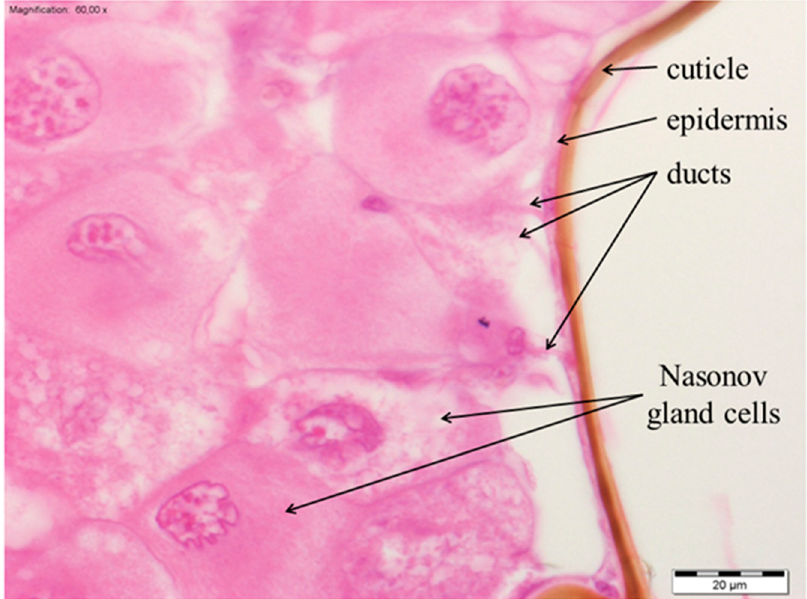
Figure 3. Nasonov gland cells in normal workers. Hematoxylin and eosin staining.